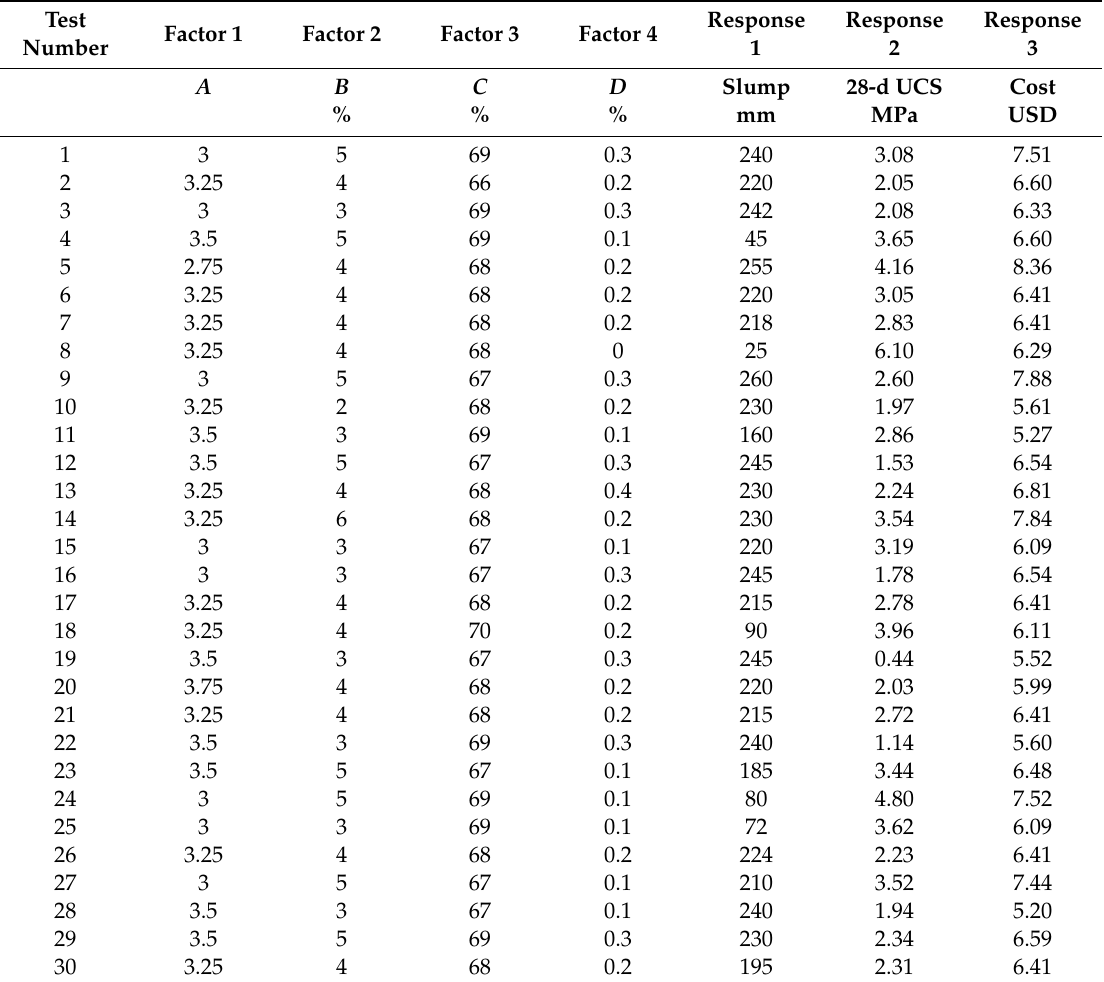
Table 4. Central composite design (CCD) test